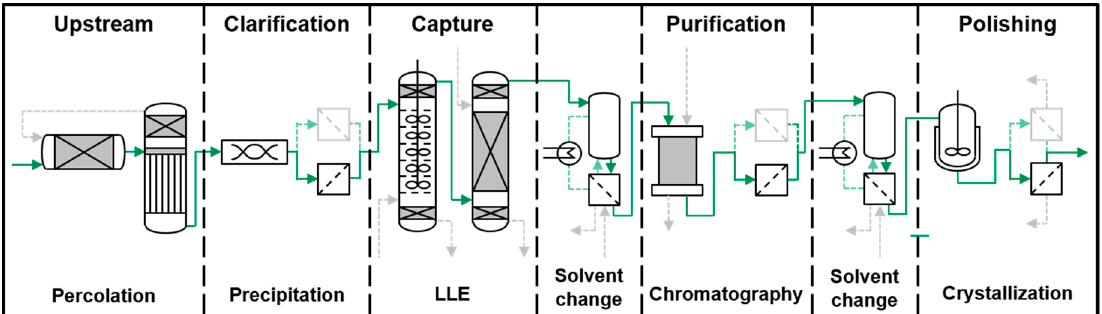
Figure 1. The basic process design for plant-based substances (LLE, liquid-liquid extraction).